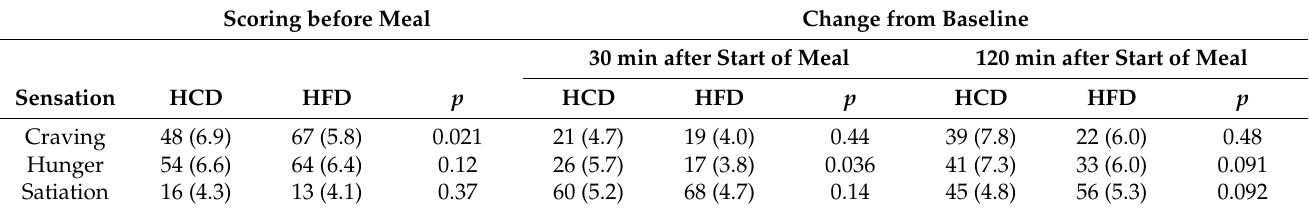
Table 1. Appetite scoring before and after a standardized test